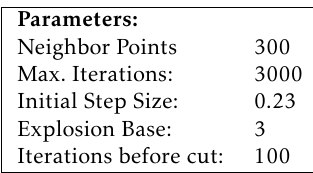
Table 2. Experimental configuration